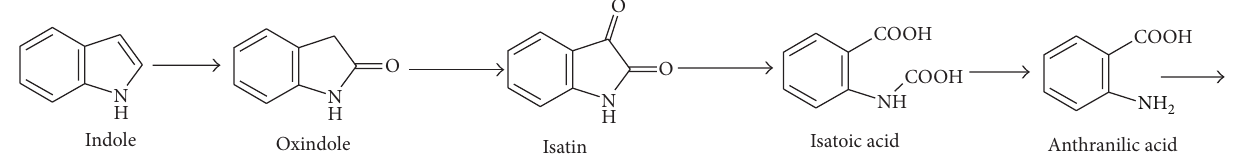
Figure 5: Anaerobic degradation pathway of indole in Desulfobacterium indolicum